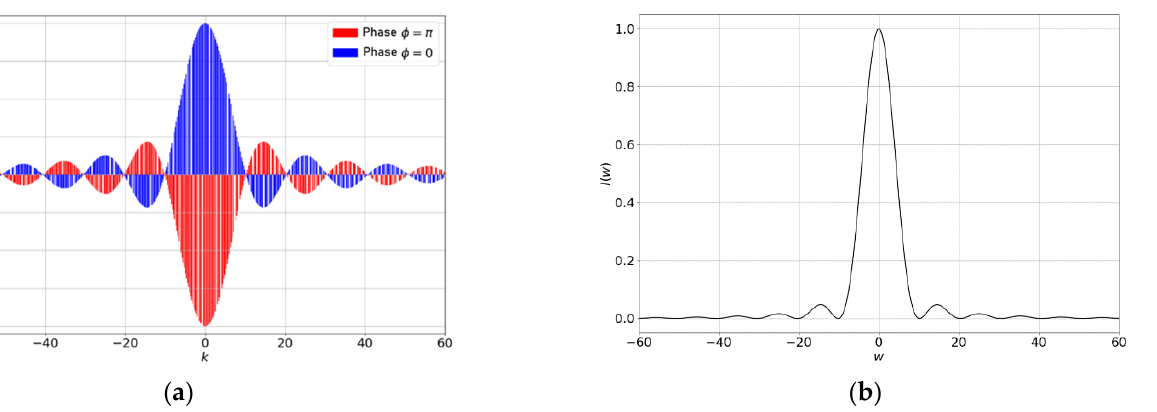
Figure 2. ( a ) Real part of the structure factor for the Fibonacci chain with distinction for even/odd m values (phase factor 0/ π ). ( b ) Reduced diffraction pattern 𝐼(𝑤) .